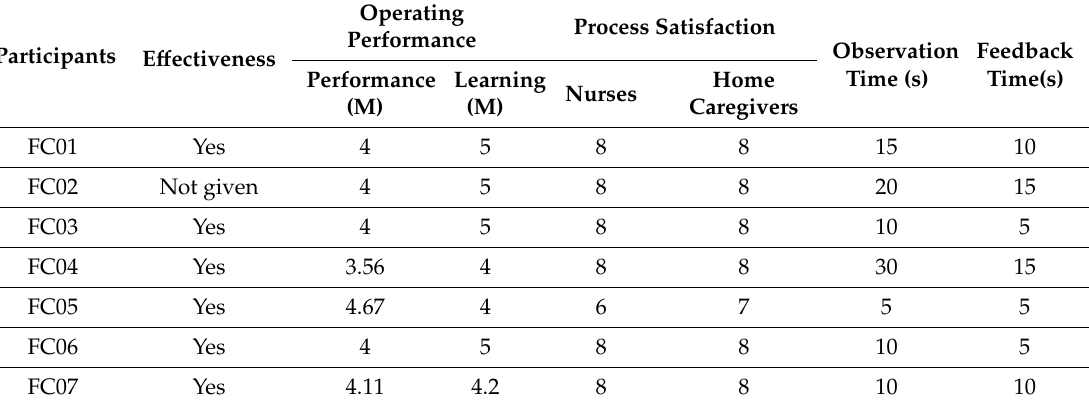
Figure 7. Participants in the third cycle. Table 3. Assessed effectiveness of use by home caregivers.